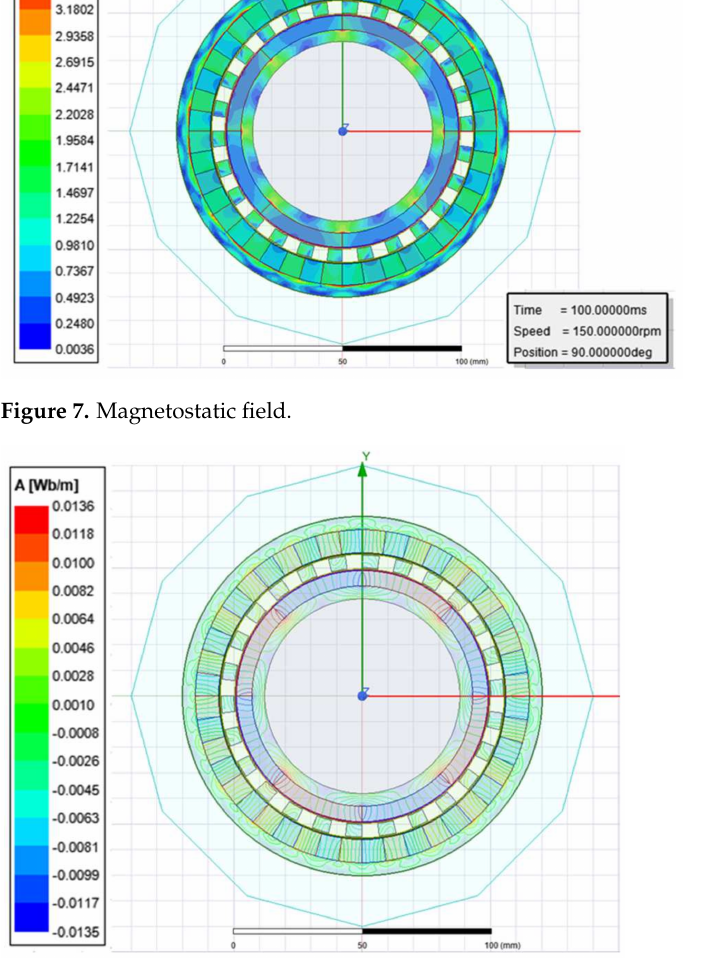
Figure 8. Magnetic flux